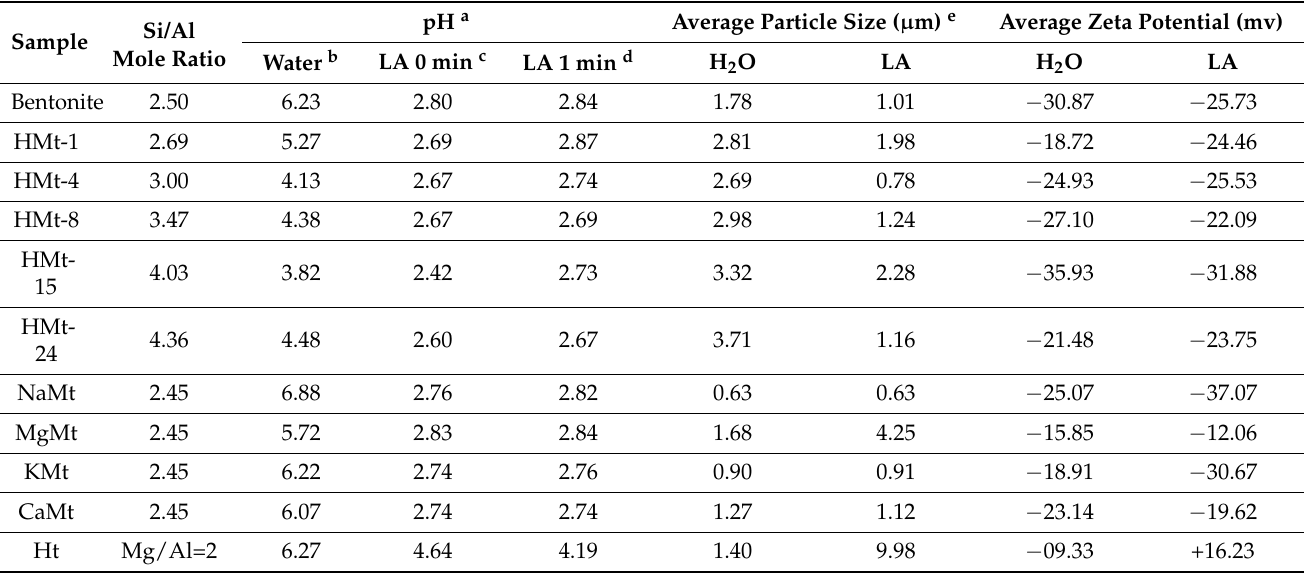
Table 1. Main behavior features of the investigated clay materials in water and LA